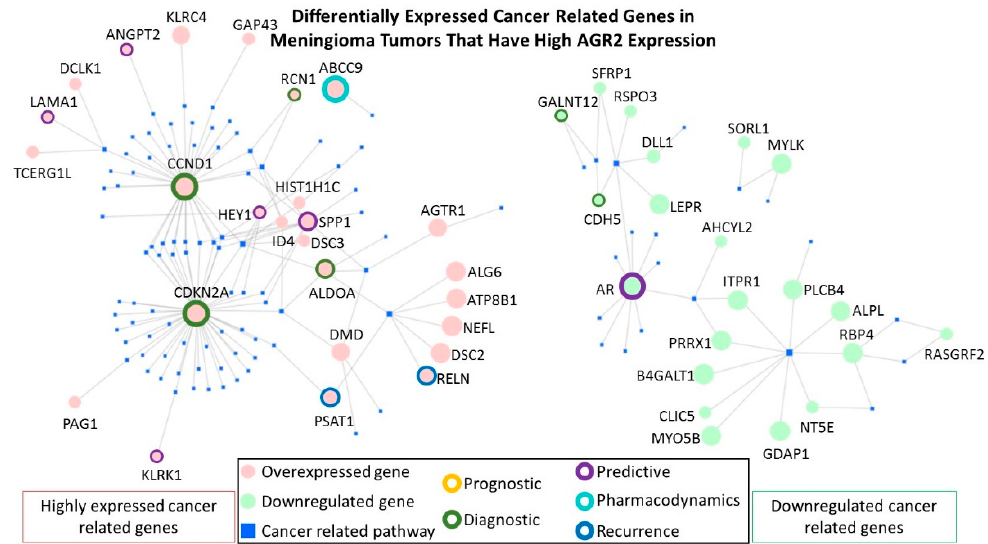
Figure 6. The most clinically relevant di ff erentially expressed cancer-related genes in meningioma tumors that have high AGR2 expression.